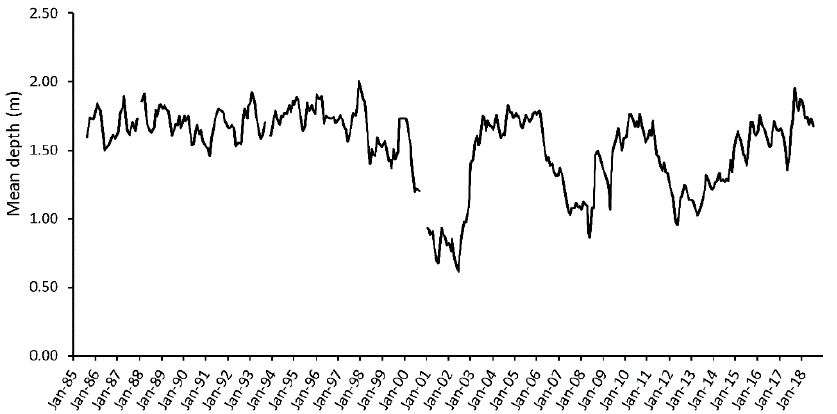
Figure 2. The history of variation in mean lake depth during the period when water quality data have been collected from 1985 to 2018.